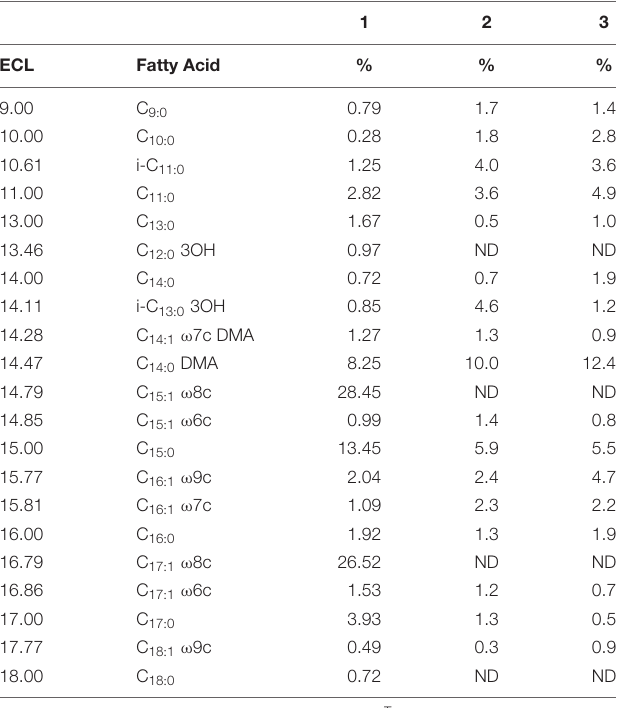
TABLE 3 | Equivalent chain length (ECL) and fatty acid composition (%) of “ P. lilae ” UFO1 and comparator